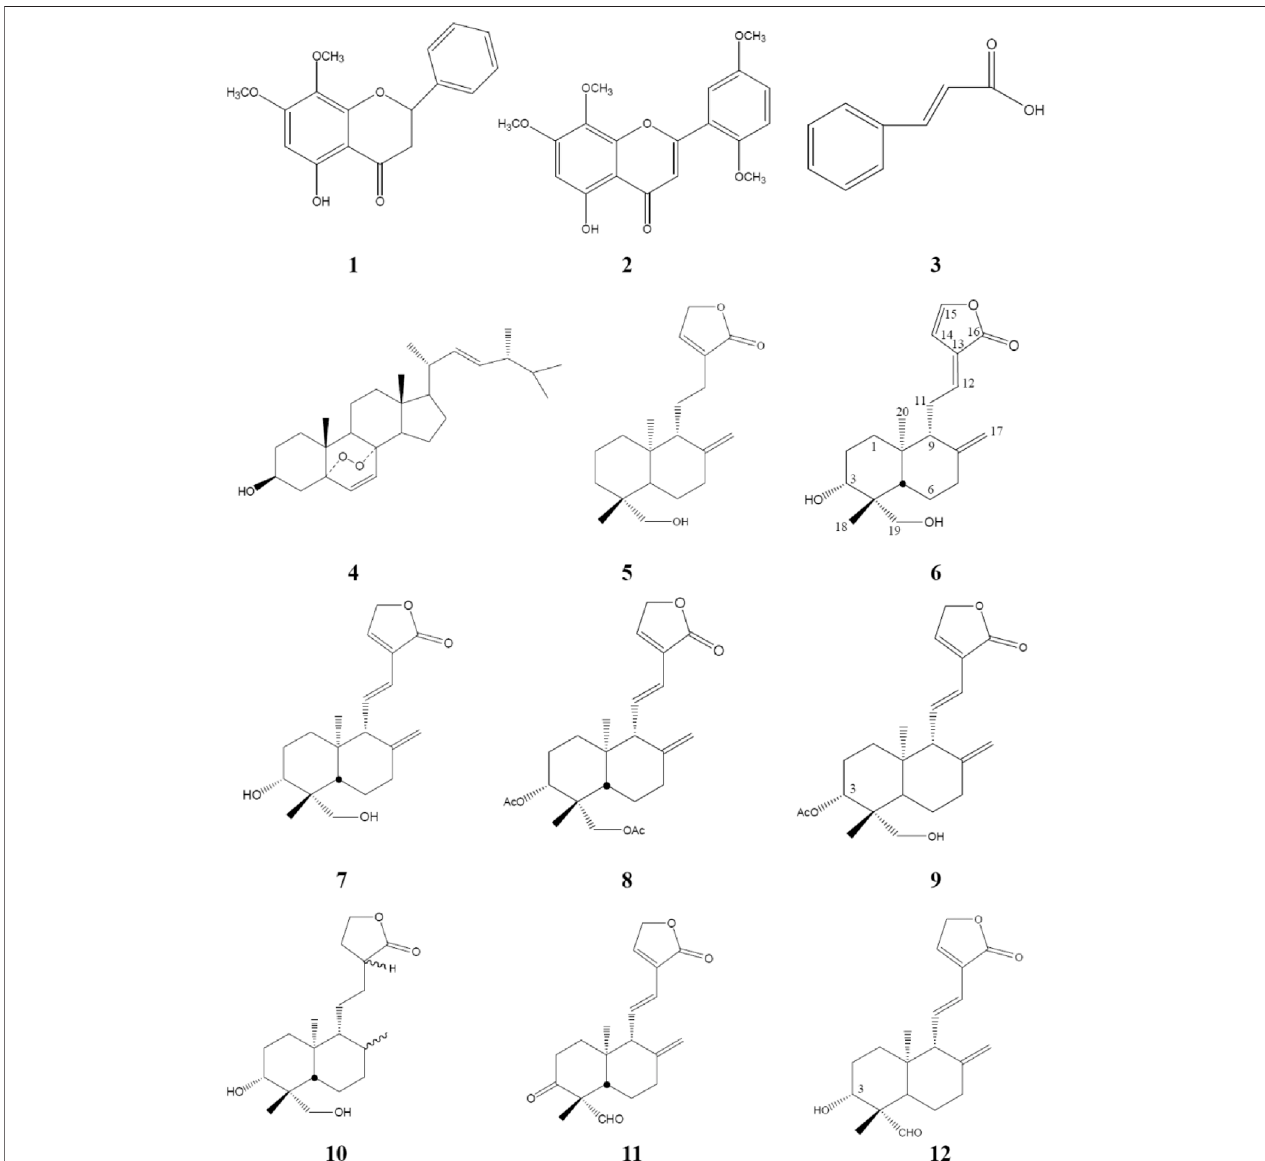
FIGURE 2 | Chemical structures of compounds 1 – 12 isolated or semi-synthesized from AP. AP, Andrographis paniculata .